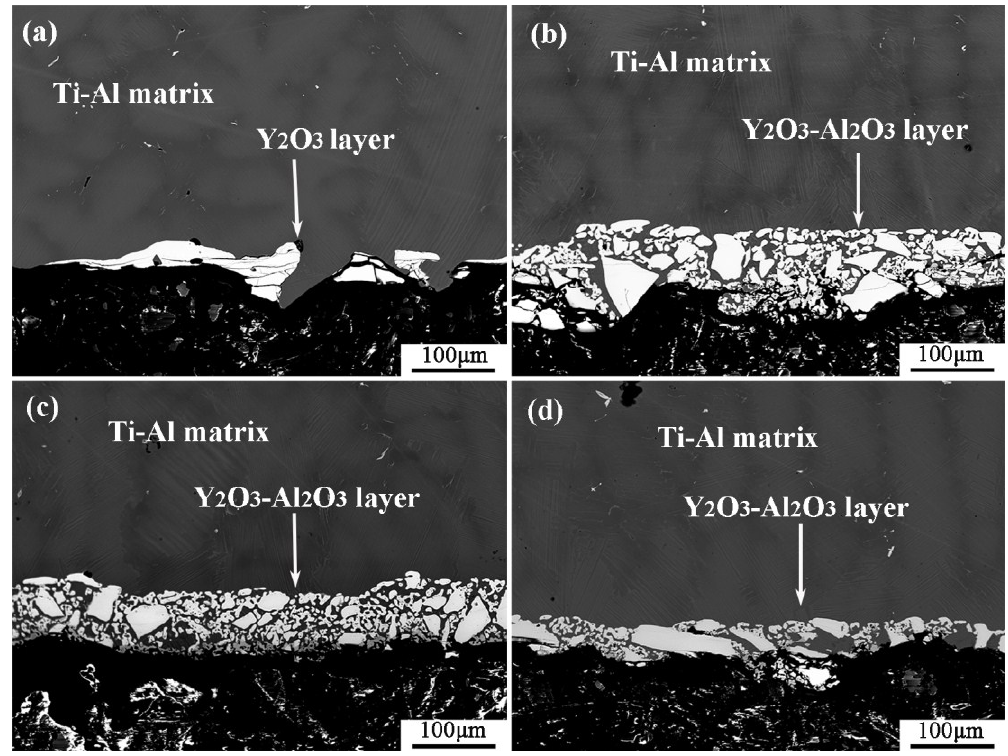
Figure 3. Microstructure of the melt-crucible contact interface. ( a – d ) represent the pure Y 2 O 3 , Al 2 O 3 -A, Al 2 O 3 -B and Al 2 O 3 -C crucibles, respectively.